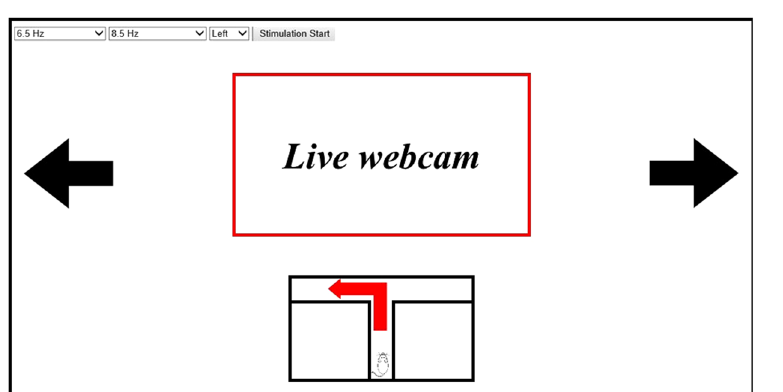
Figure 6. Design of the